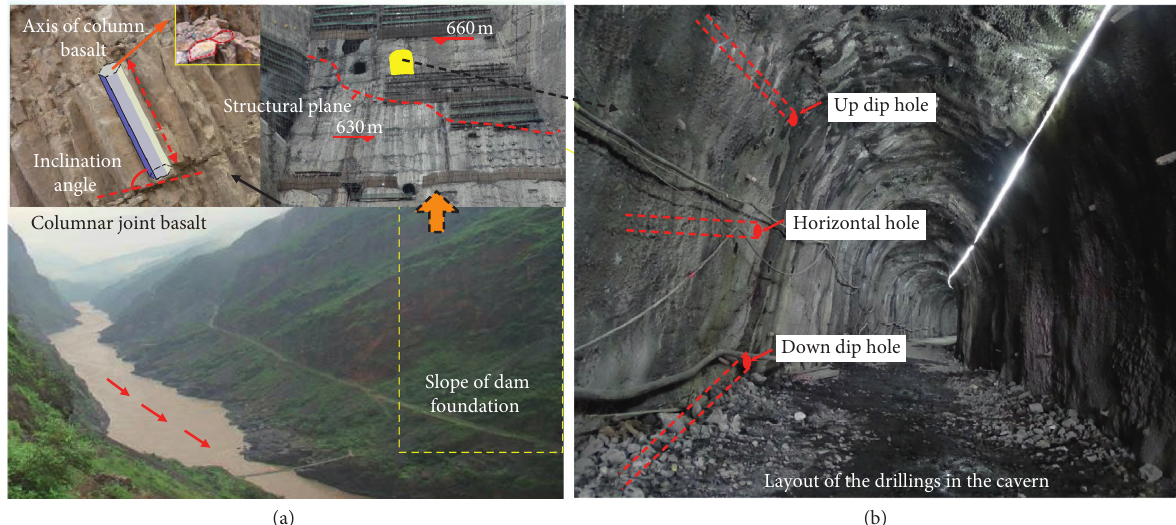
Figure 6: Columnar joint basalt on the slope of dam foundation in Baihetan.